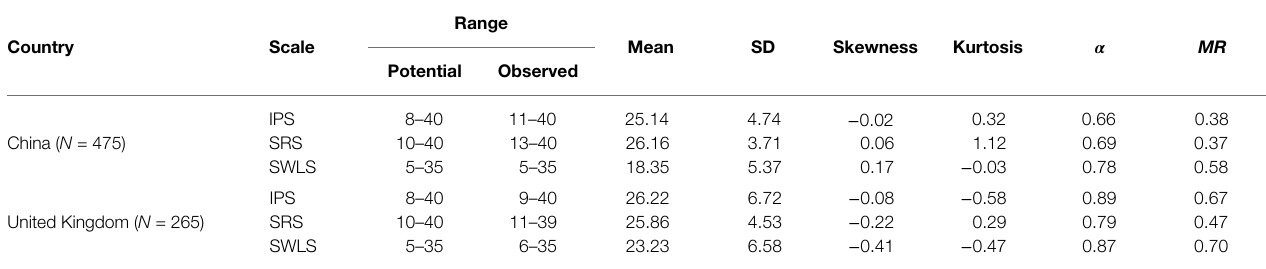
TABLE 1 | Descriptive scale statistics for the SRS in China and the United Kingdom.